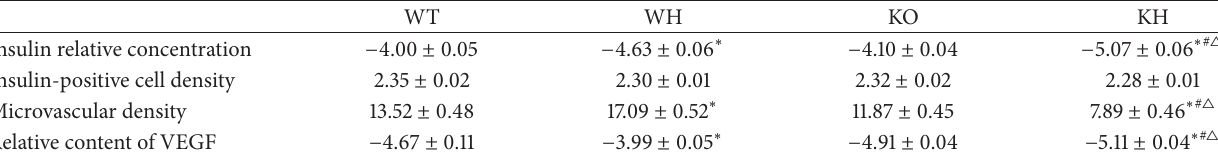
Table 2: Data of immunohistochemistry (mean ± SD).